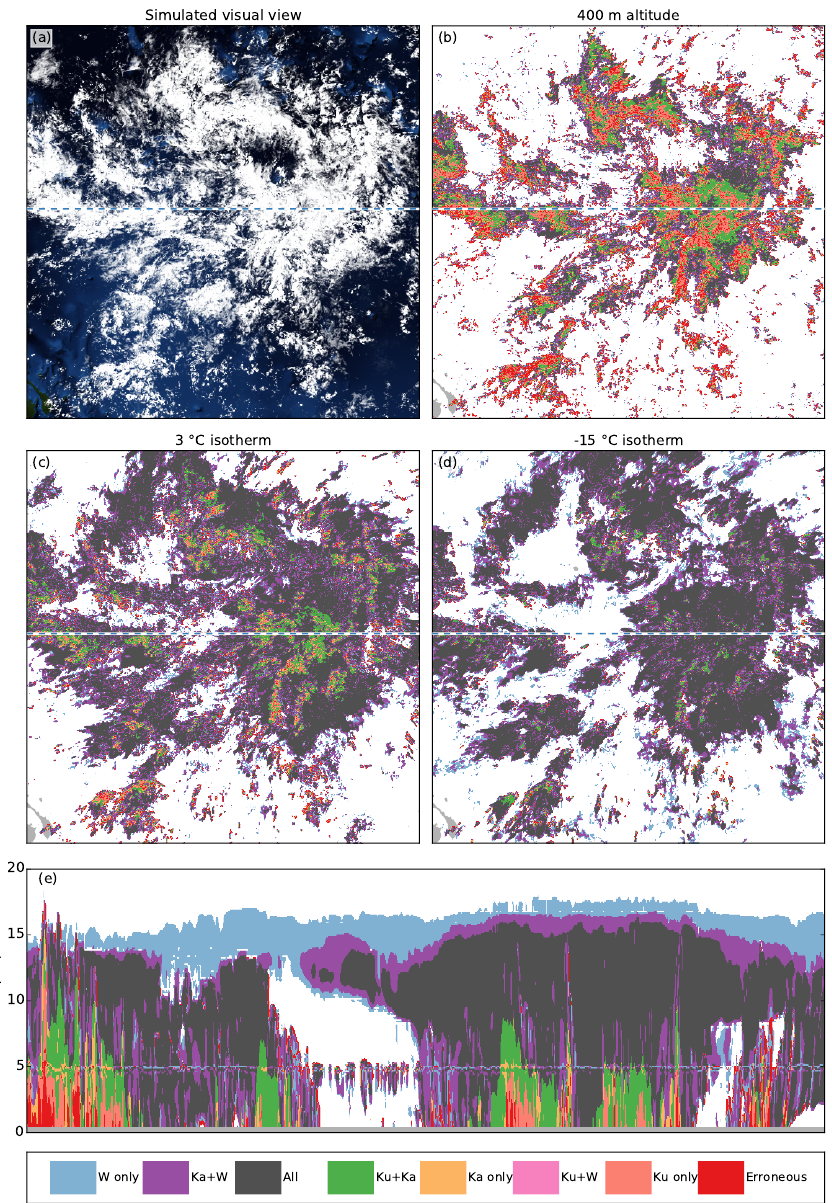
Figure 6. An overview of the radar band availability in the case study of tropical maritime organized convection (Sect. 5.2; TMC in Fig. 3). (a) A simulated visual view, generated as with Fig. 3a. (b) The radar band availability at the 400m level. (c) As in (b) , but at the 3 ◦ C isotherm. (d) As in (b) , but at the − 15 ◦ C isotherm. (e) A vertical cross section of the region along the blue–white dashed line shown in (a–d) .